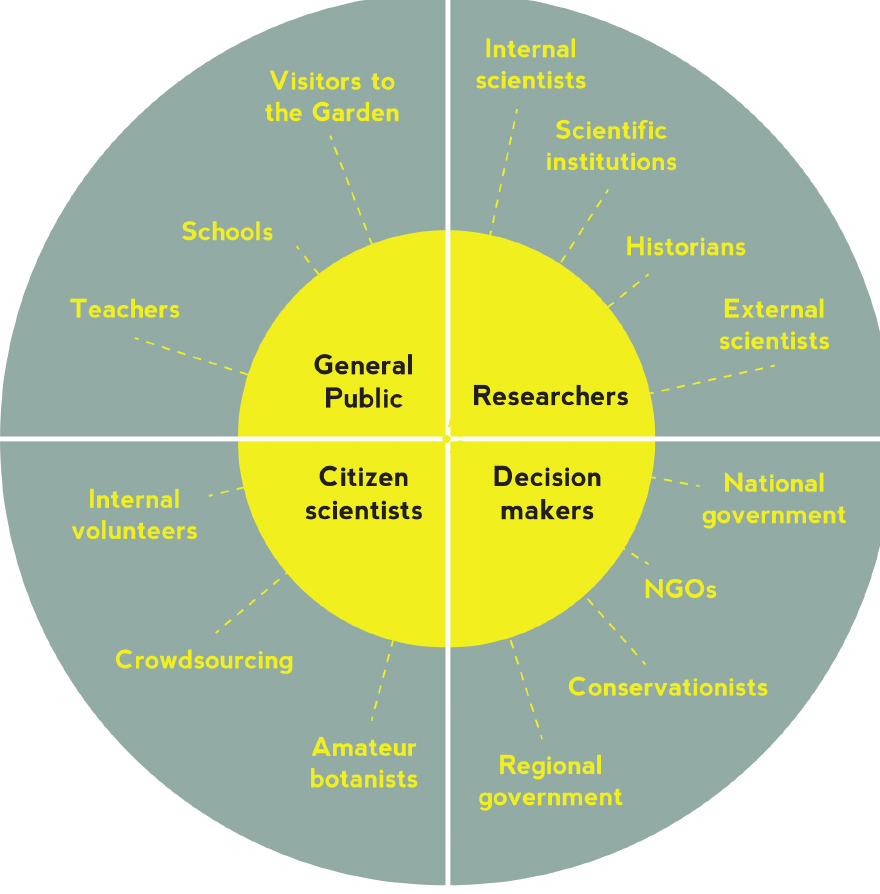
Figure 1. Stakeholders interacting with the Botanic Garden Meise and potentially using its data portal. The stakeholders prefixed by the words ‘internal’ refer to those that work at the Botanic Garden, whereas those referred to as ‘external’ refer to researchers in other